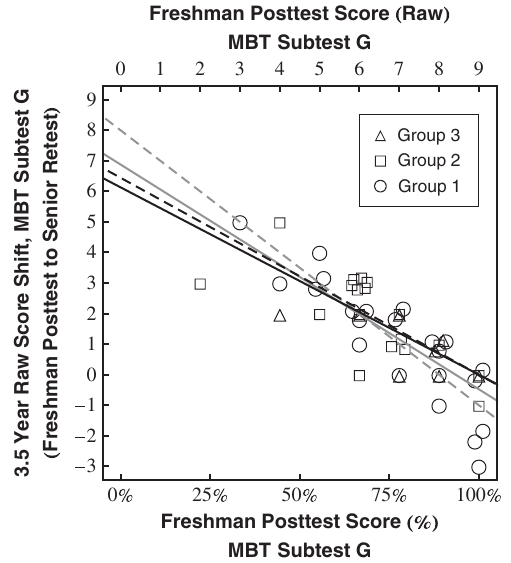
FIG. 4. Score shift from the end of freshman mechanics to graduation on subtest G of the MBT versus freshman posttest score on the same subtest. The solid lines are fits to the data for all groups (gray with floating intercept, black with x intercept fixed at 9). The dashed lines are fits to the group 1 data (gray with floating intercept, black with x intercept fixed at 9). The floating fit to the entire group has an x intercept of 8 : 42 (cid:5) 0 : 31 , consistent with an x intercept of 9. The fixed fit to the entire group implies a normalized gain of 0 : 68 (cid:5) 0 : 05 over the 3.5 years since taking freshman mechanics.